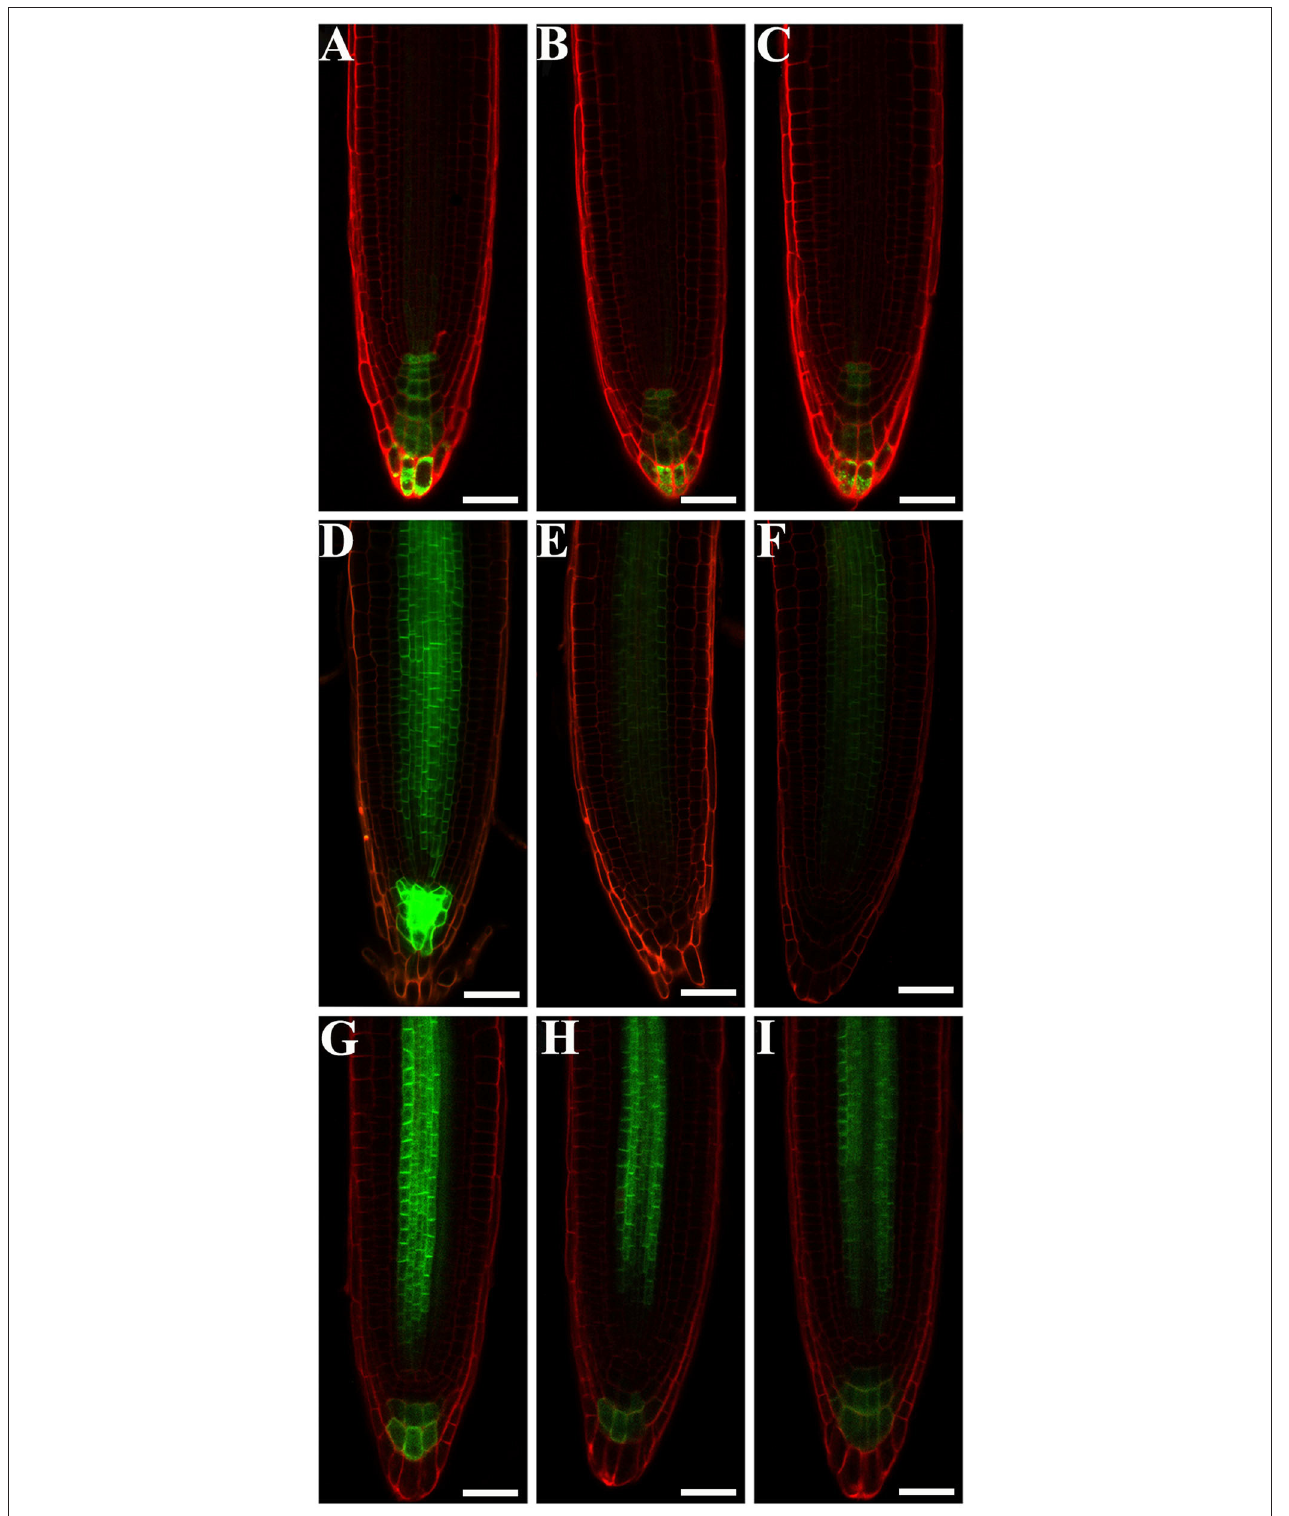
FIGURE 4 | eIF4E1 regulates the expression of auxin-responsive report gene and the accumulation of PIN3 and PIN7 proteins. (A–C) DR5 rev :GFP is expressed in roots of 4-day-old wild type (A) , eif4e1-1 (B,C) . “L1” and “L2” designate two lines of eif4e1-1 crossed by DR5 rev :GFP . (D–F) PIN3 pro :PIN3-GFP is expressed in roots of 4-day-old wild type (D) , eif4e1-1 (E,F) . “L1” and “L2” designate two lines of eif4e1-1 crossed by PIN3 pro :PIN3-GFP . (G-I) PIN7 pro :PIN7-GFP is expressed in roots of 4-day-old wild type (G) , eif4e1-1 (H,I) . “L1” and “L2” designate two lines of eif4e1-1 crossed by PIN7 pro :PIN7-GFP . Scale bars: 20 µ m.